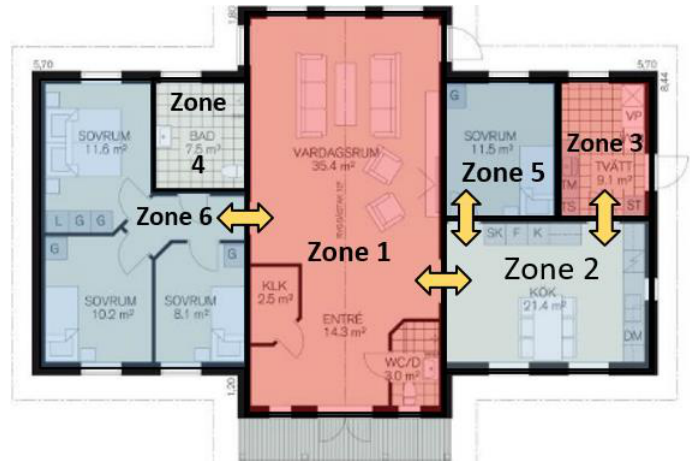
Figure 1. Layout of the building that is modeled with 6 thermal zones. Zones 1 and 3 are the ones that are used when